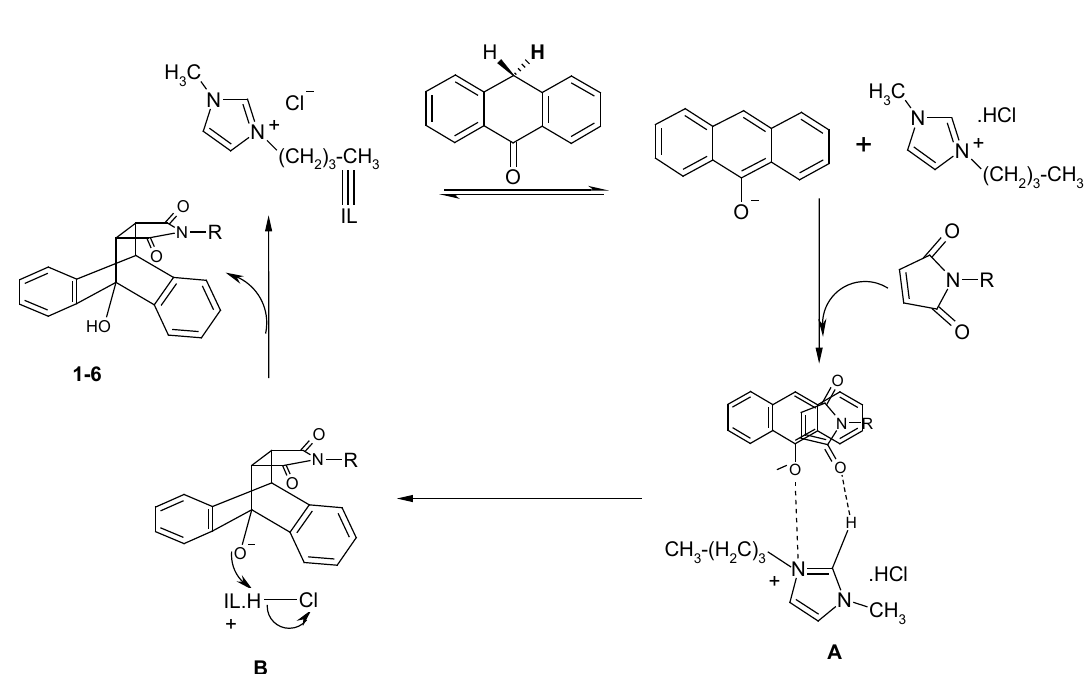
Figure 1. Possible transition state and reaction